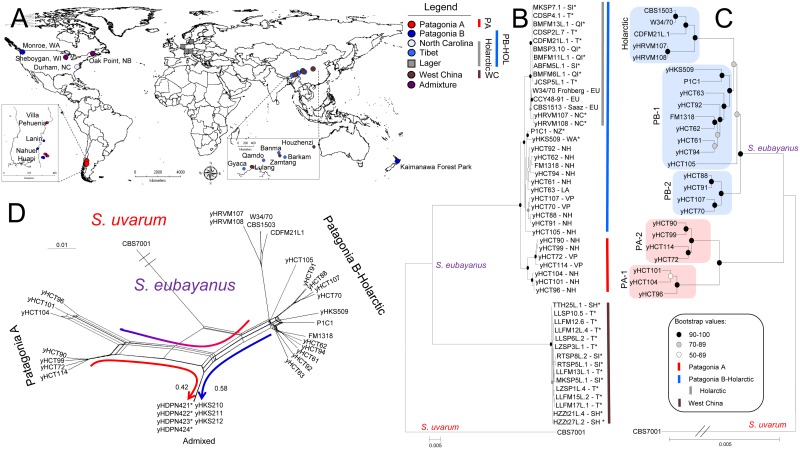
S. eubayanus distribution and phylogeography.A) Geographic distribution of S. eubayanus isolates. B) Maximum-Likelihood (ML) phylogenetic tree reconstructed using the concatenated multi-locus Dataset A (S1 Text). Bar colors are defined in the legend in panel A. Asterisks highlight new isolates or strains not previously studied together [20]. EU: Europe; QI: Qinghai (China); LA: Lanin (Argentina); NC: North Carolina (USA); NH: Nahuel Huapi (Argentina); NZ: New Zealand; SH: Shaanxi (China); SI: Sichuan (China); T: Tibet (China); VP: Villa Pehuenia (Argentina); WA: Washington (USA). C) ML phylogenetic tree reconstructed using the complete genome sequence data. Phylogenetic trees were rooted using S. uvarum (CBS7001) as the outgroup. The scale bars show the number of substitutions per site. The strain FM1318 is a monosporic derivative of CRUB1568T (= CBS12357T = PYCC6148T). Bootstrap values above 50 are reported at their corresponding nodes. D) Neighbor-Net phylogenetic network reconstructed with the SNP dataset. In phylogenetic networks, incongruent data are represented by nodes subtended by multiple edges. Blue and red arrows indicate the fractional genomic contributions from PB-1 and PA-2, respectively. The scale bar represents the number of substitutions. Note that the admixed strains from Wisconsin [20] and New Brunswick (Fig 2) are only shown in panel D to avoid implying a linear bifurcating ancestry.